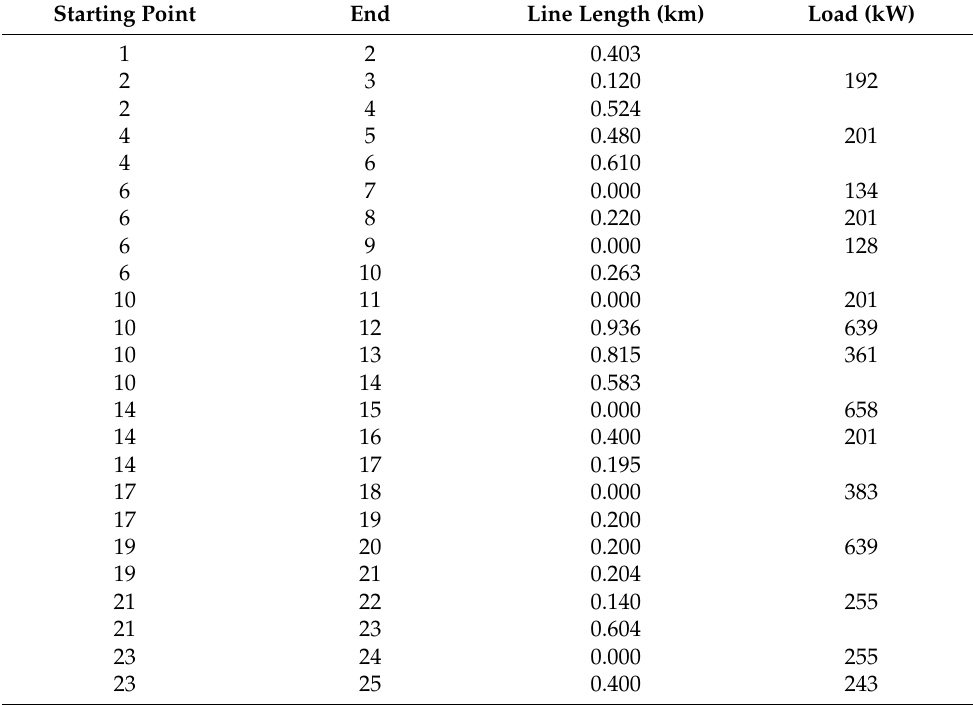
Table 1. Piece of the actual feeder data.